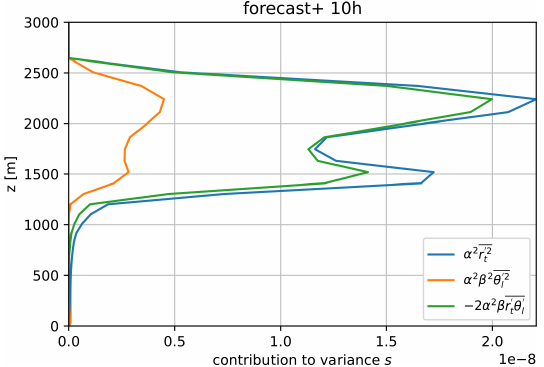
Figure 13. ARM case, 10th simulation hour. The convective con- tribution to the variance in s of cy40NEW from the variance in θ l (orange), total mixing ratio r t (blue), and the covariance (green); see Eq.